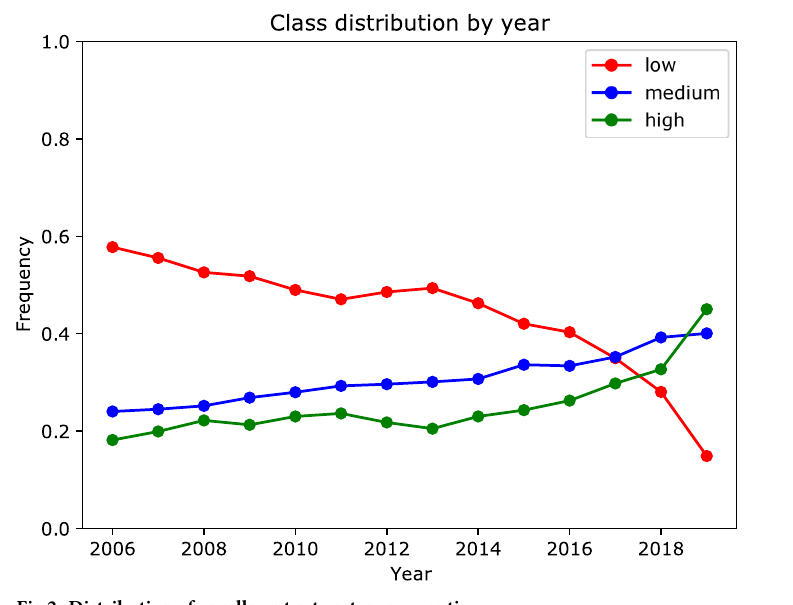
Fig 2. Distribution of enrollment rate category over